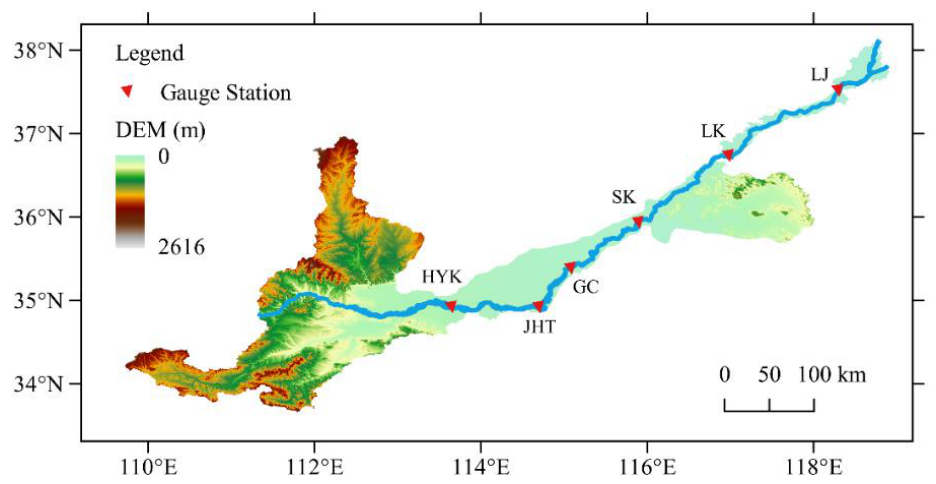
Figure 1. Sketch map of the locations of gauge stations in the LYR used in this study.